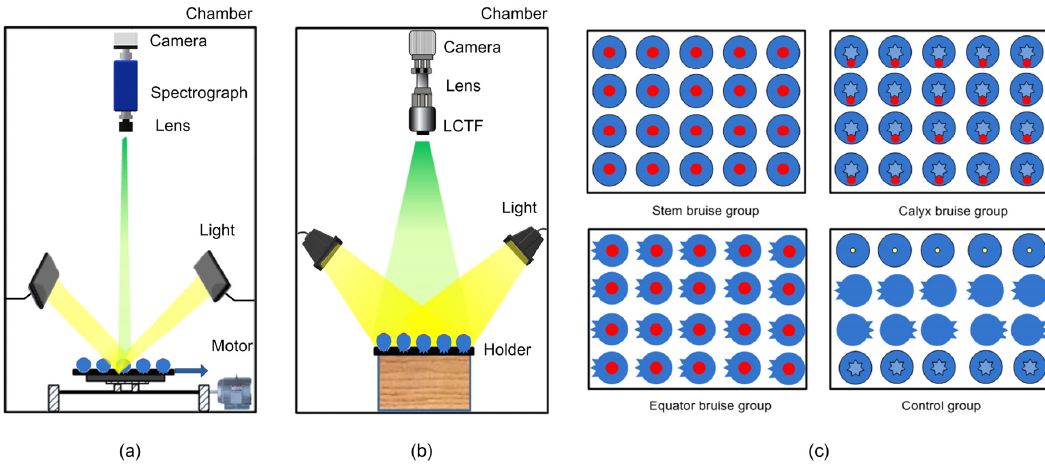
Figure 1. Schematic diagram of the ( a ) push broom based and ( b ) liquid crystal tunable filter (LCTF) based hyperspectral imaging system, and ( c ) blueberry orientations used for acquiring images.